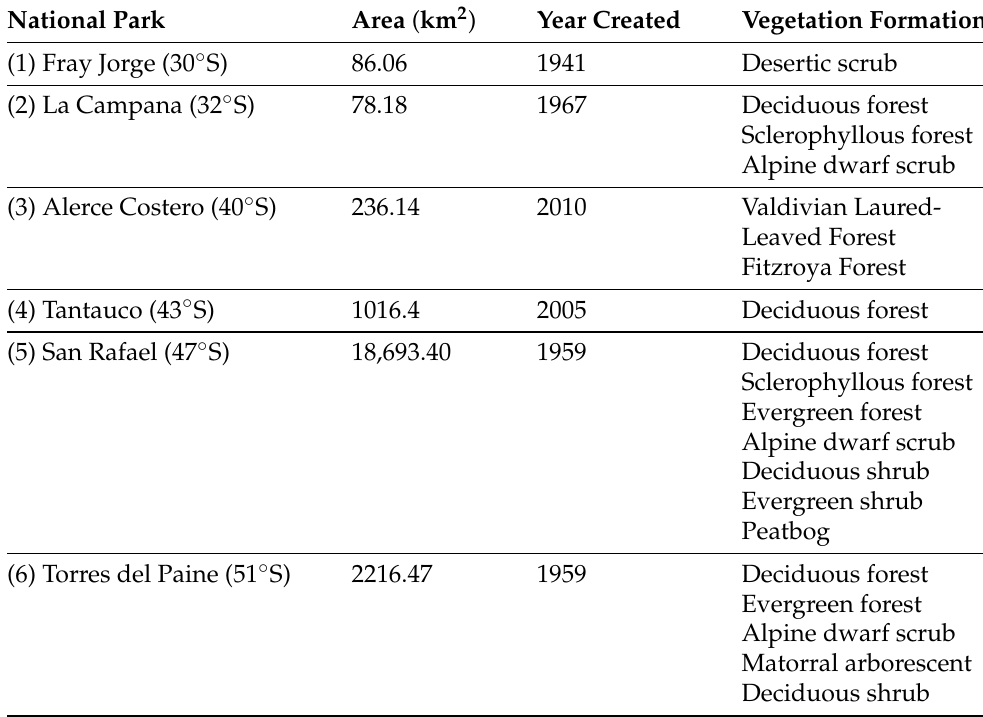
Table 1. Vegetation formations in National Parks of this study according to Pliscoff and Fuentes- Castillo